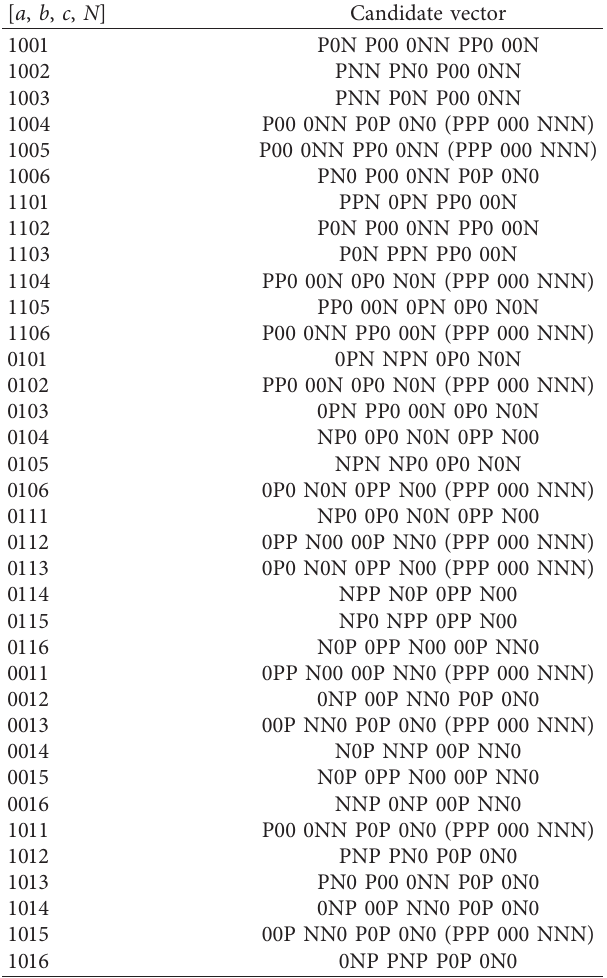
Table 1: Selection guide for candidate vectors based on a , b , c , and N . [ a , b , c , N